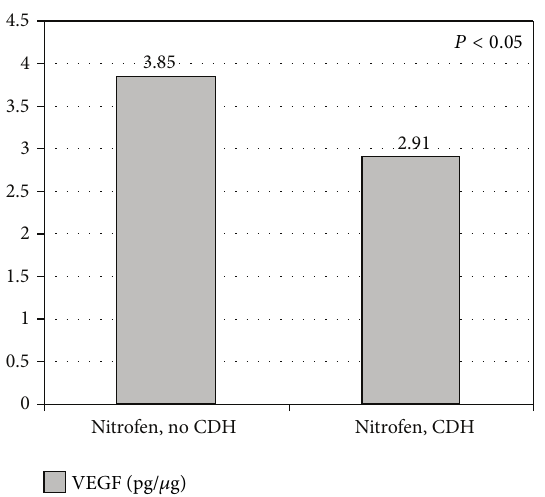
Figure 4: Vascular endothelial growth factor VEGF in Group 2 (nitrofenfetuses).ComparingfetuseswithandwithoutCDH.Values are expressed as mean in pg/ 𝜇 g.